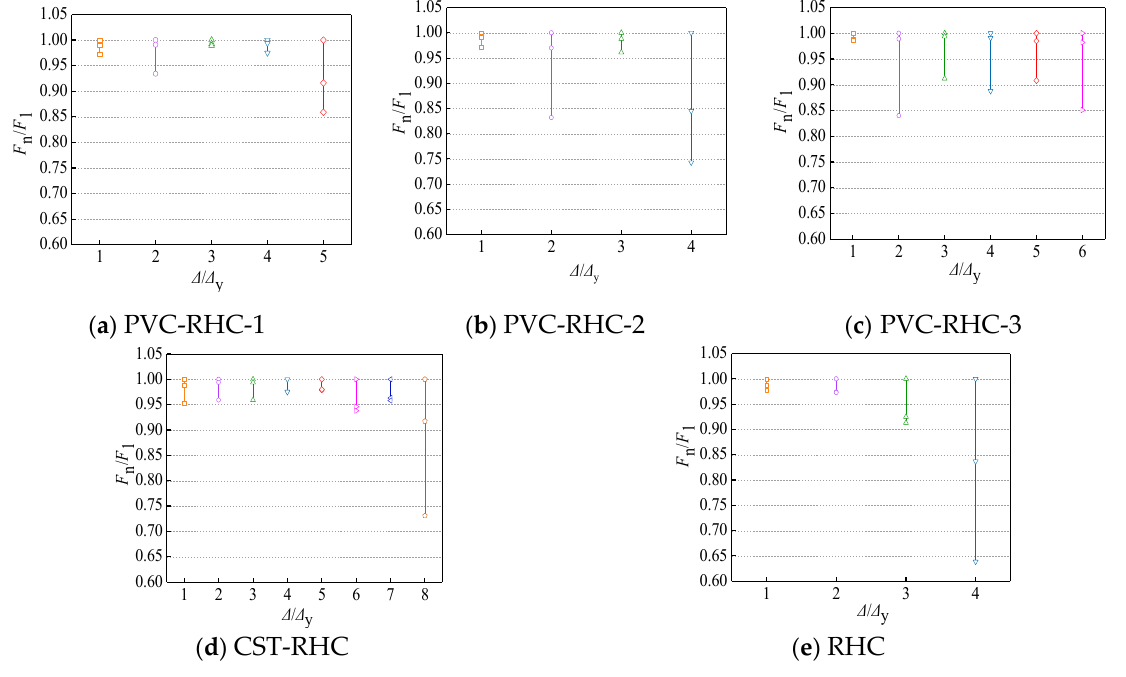
Figure 12. Strength degradation curves.